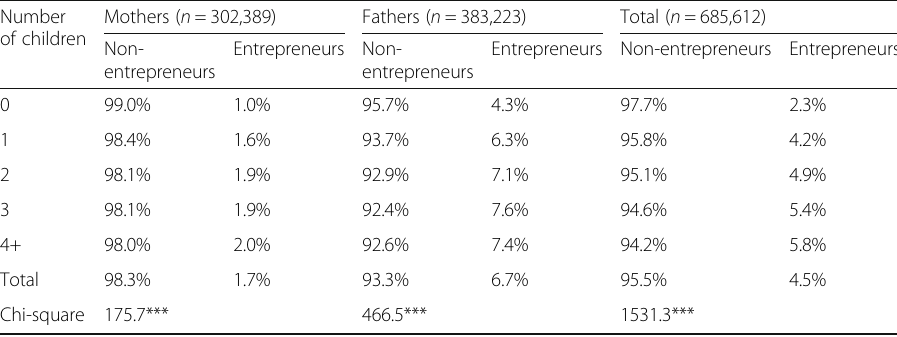
Table 2 Number of children and businesses ownership among parents Number Mothers ( n = 302,389) of children